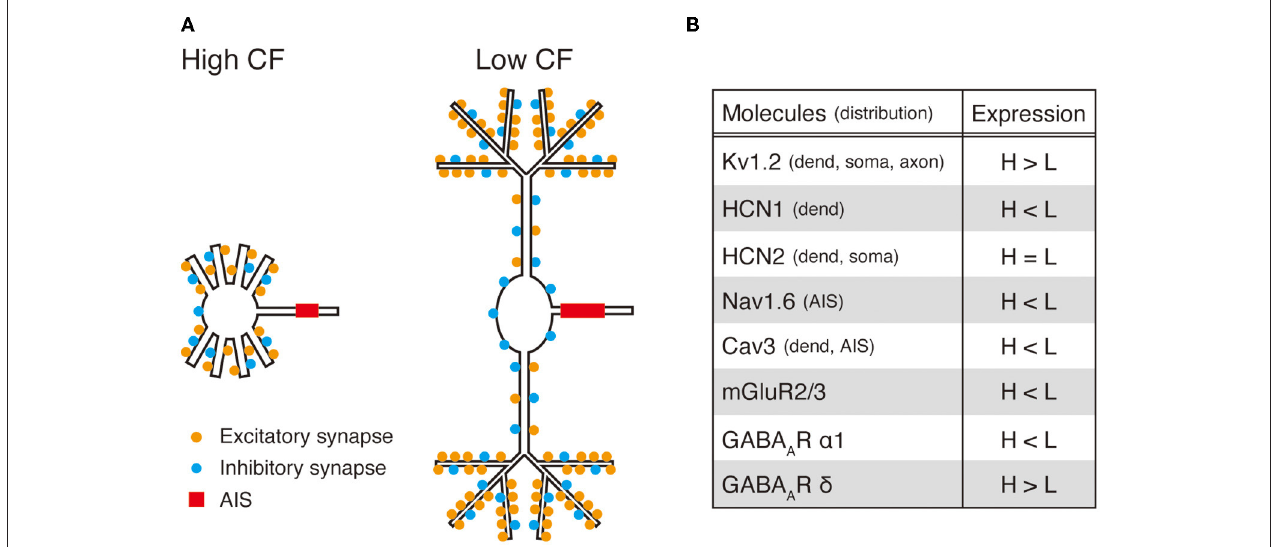
FIGURE 2 | Summary of tonotopic refinements in chick NL neurons. (A) Tonotopic differences in excitatory and inhibitory synapses (location and density) and AIS (location and length) are shown in schematic drawings of neurons with high and low characteristic frequency (CF). (B) Location of ion channels and receptors and their tonotopic differences in expression are